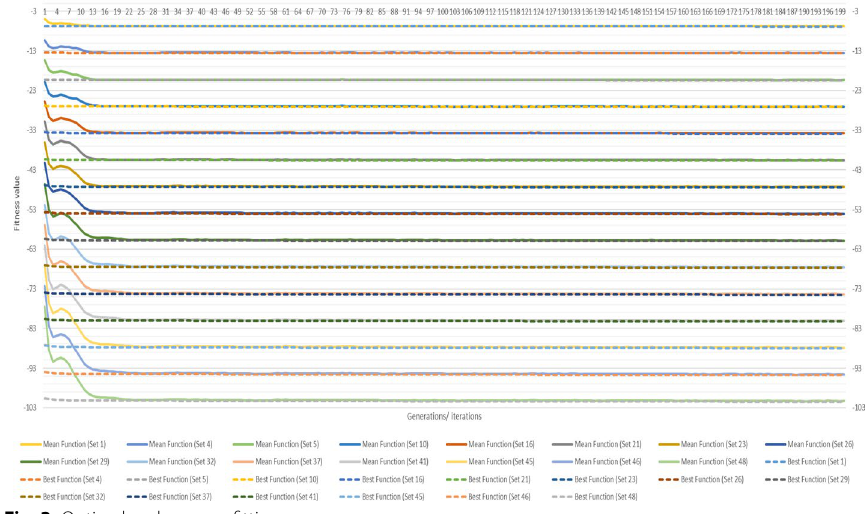
Fig. 3 Optimal and average fitting process